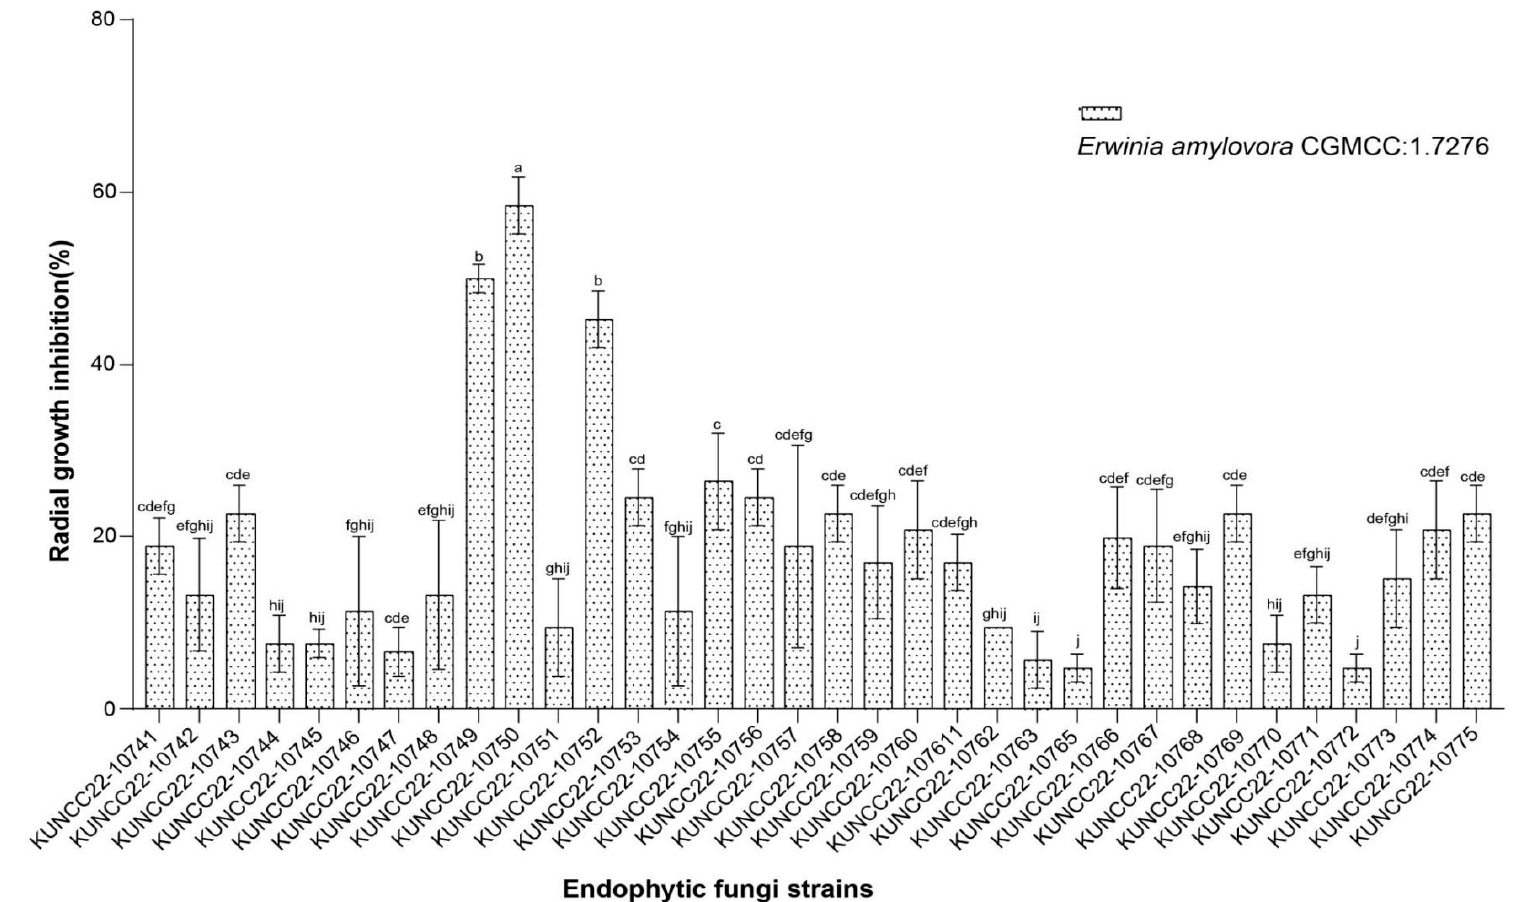
Figure 6. Inhibition rates of different fungal endophytes to bacterial pathogen Erwinia amylovora (GCMCC: 1.7276). The bars denoted by the same letter are not significantly different from each other.